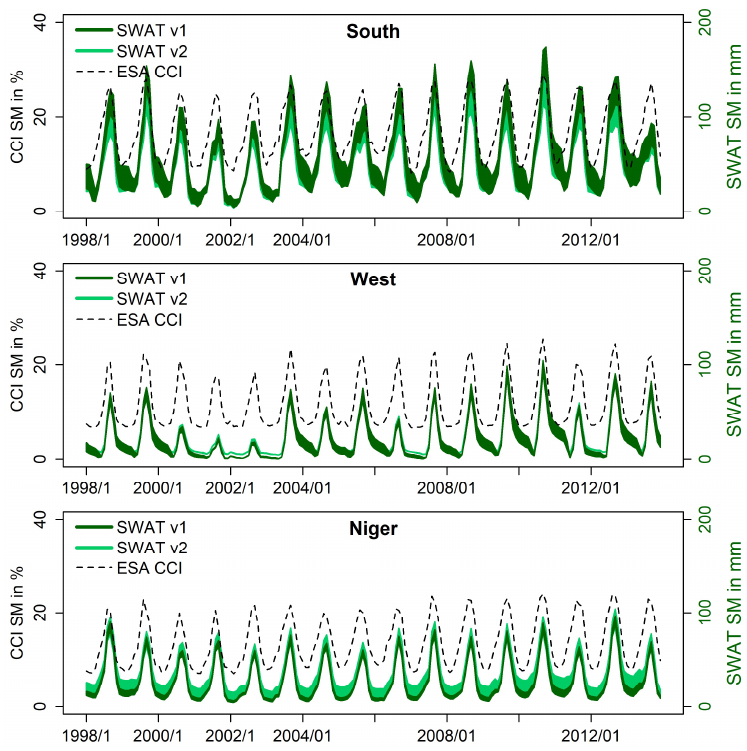
Figure 7. Monthly Simulated Soil Moisture Validation against ESA CCI Data, where SWAT v1 is the global and v2 the local calibration. Table 6. Total Water Storage Validation against GRACE Data.